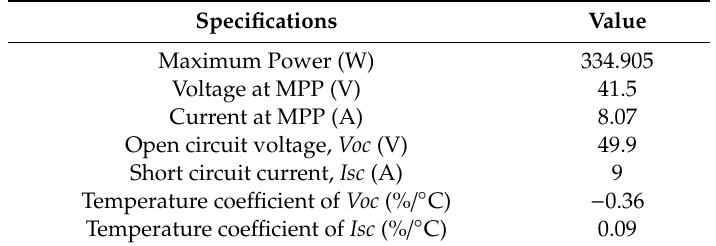
Table 1. Specifications of American Choice Solar ACS-335-M photovoltaic (PV)